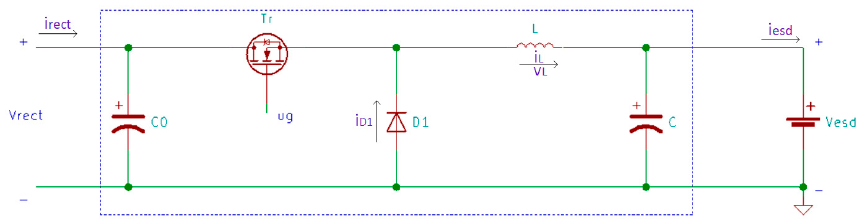
Figure 18. DC-DC converter in the two-stage energy harvesting scheme.